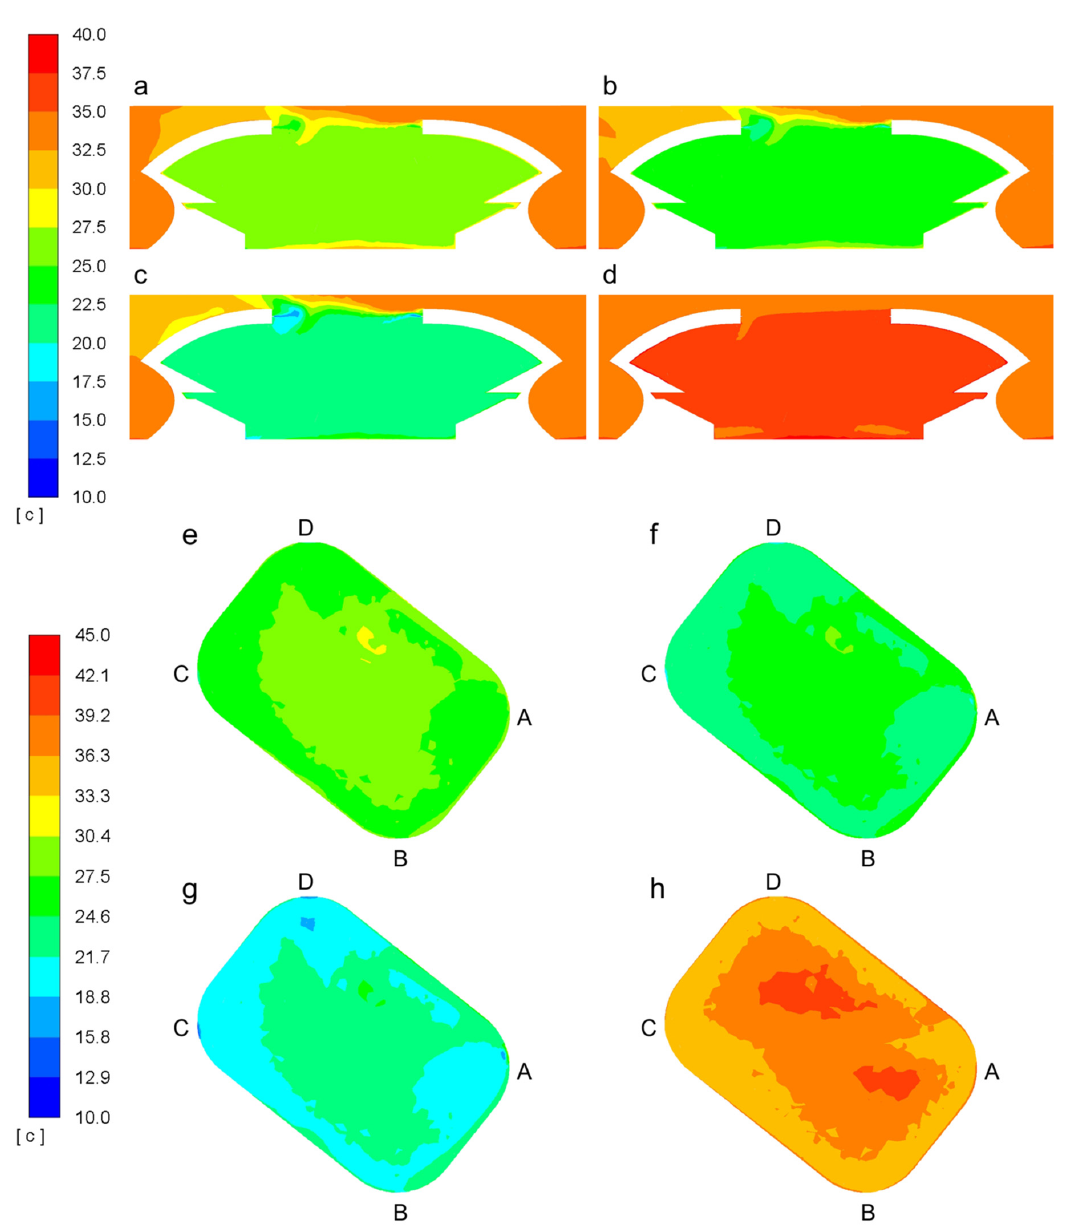
Figure 13. ( a – d ) Temperature contours of the cross-section of the stadium for scenarios four to six and for the baseline stadium. ( e – h ) Temperature contours of the pitch for scenarios four to six and for the baseline stadium.